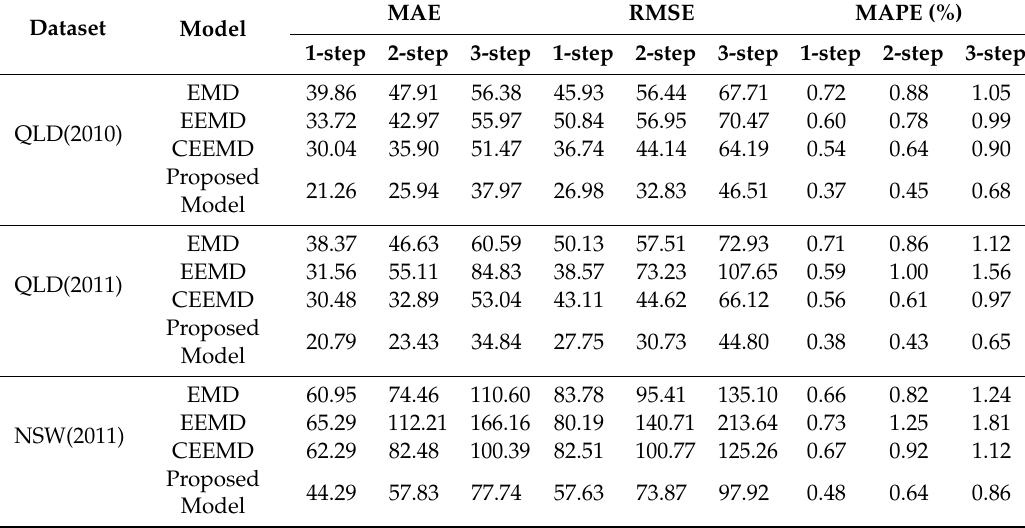
Table 4. Comparison of forecasting performance of combined model and models using di ff erent data preprocessing